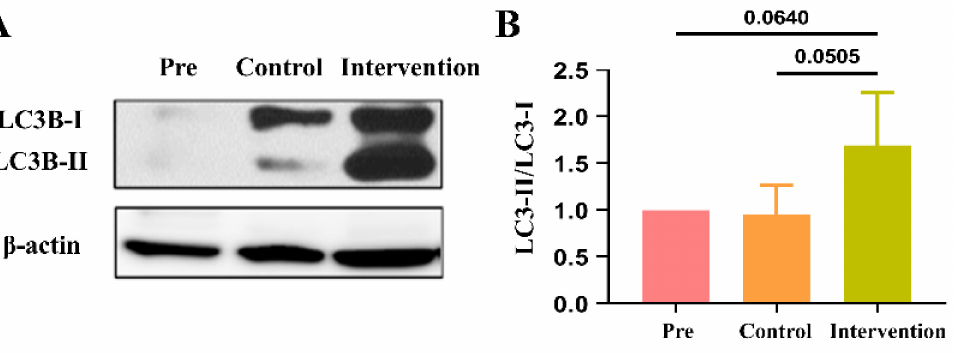
Figure 7. LC3B expression related to cell autophagy. ( A ) Western blot analysis of LC3B expression and ( B ) quantitative analysis of LC3B-II/LC3B-I expression of implanted vein